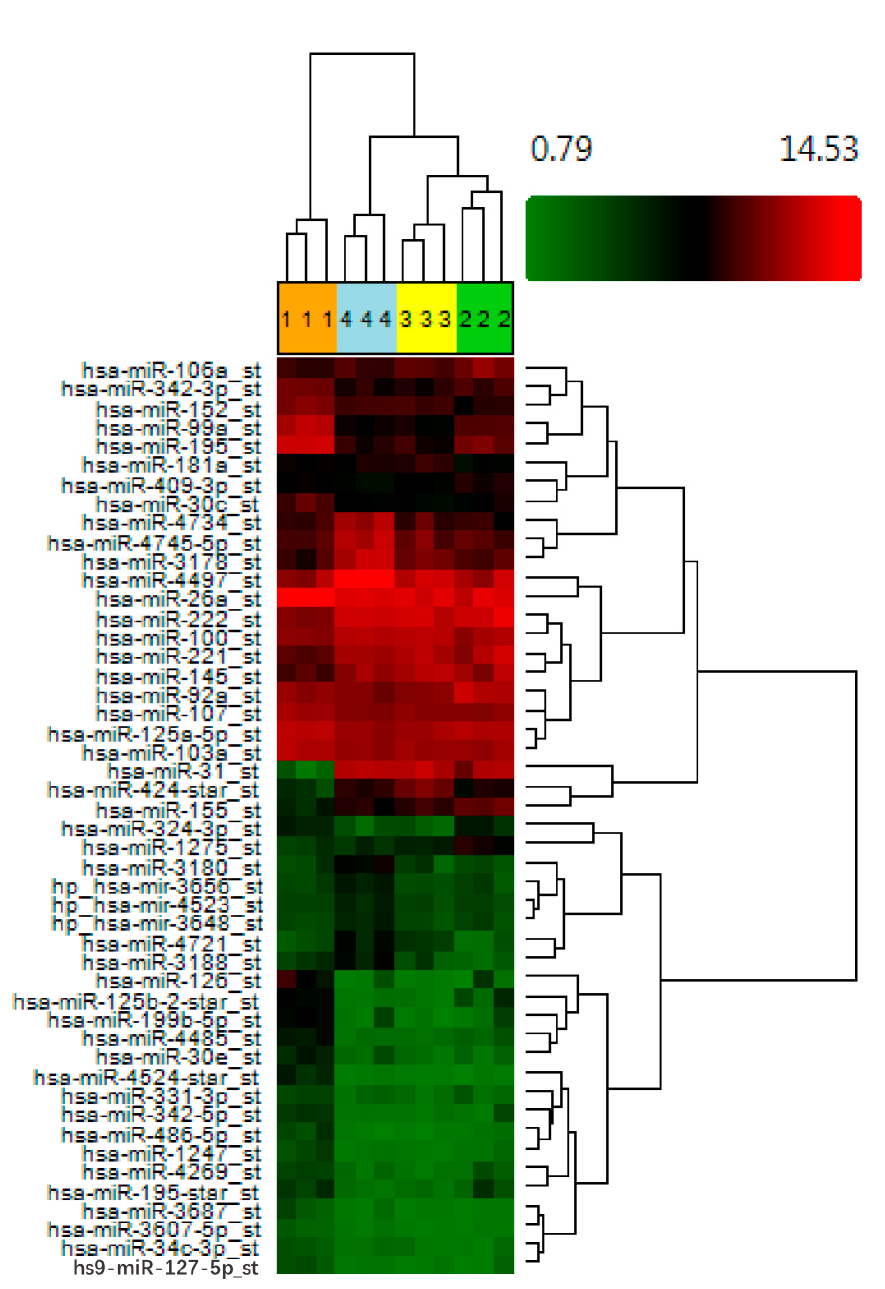
Figure 1. Compared to ex vivo ASC, cultured ASC exhibit a more similar microRNA expression profile regardless of the time spent in standard tissue culture conditions. MACS-derived ASC from three different donors were subjected to standard tissue culture conditions and microarray analysis was performed at day 0 (group 1 shown in orange), day 3 (group 2 shown in green), day 28 (group 3 shown in yellow), and day 63 (group 4 shown in blue) post sort. A heatmap and dendogram was generated using Transcription Analysis Console™ software (Affymetrix) and a list of all transcripts which exhibited a fold change > 2 (across all four conditions, with an ANOVA p value < 0.005). Green represents downregulated genes and red up regulateded genes from three donor samples.